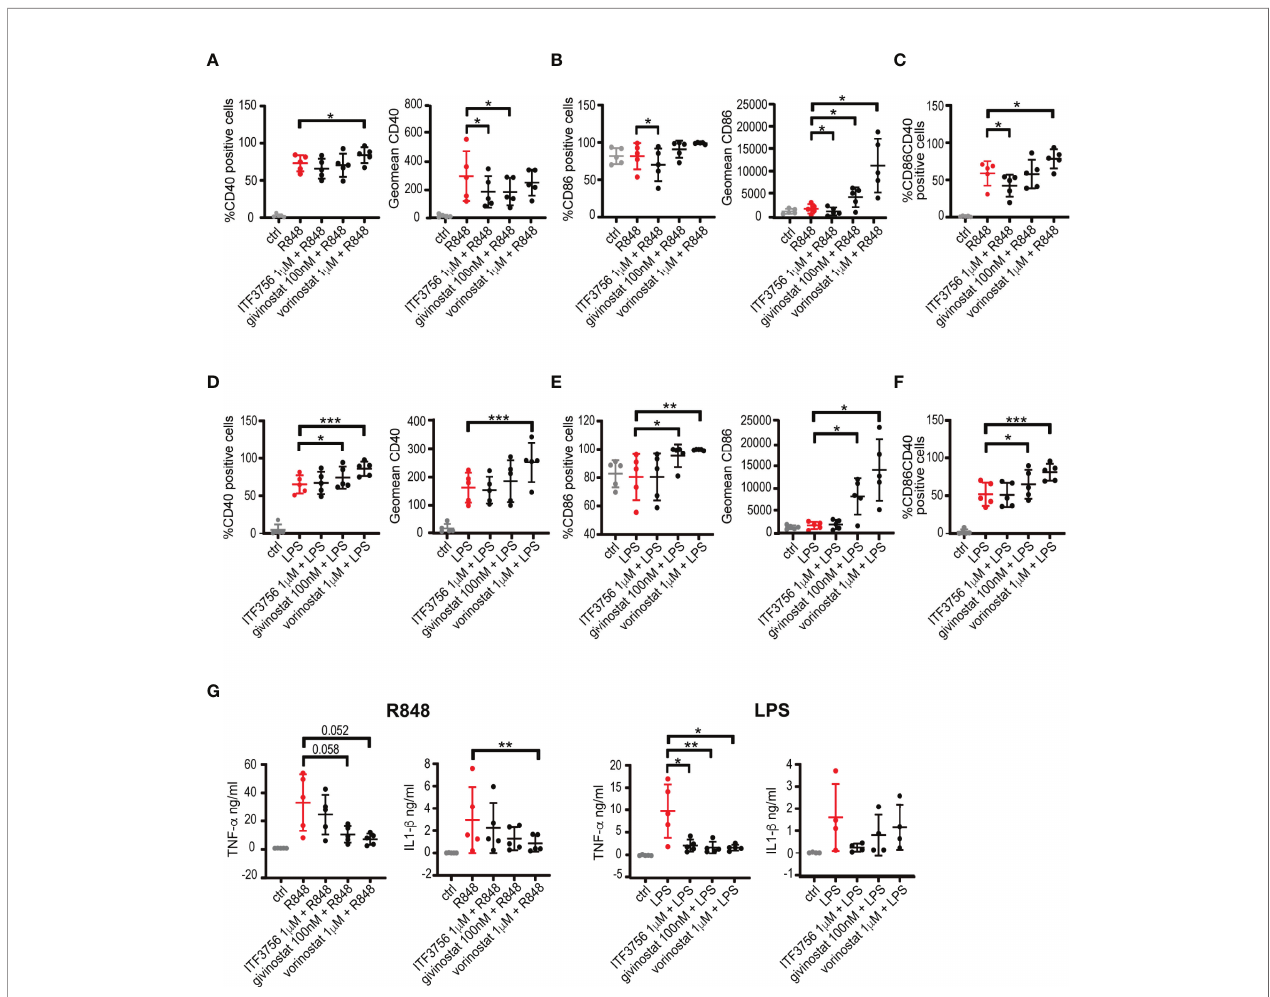
FIGURE 2 | HDACi treatment modulates CD40 and CD86 surface markers expression and pro-in fl ammatory cytokines production in LPS or R848 stimulated monocytes. Human puri fi ed monocytes pre-treated with HDACi were stimulated with LPS (1 m g/ml) or R848 (5 m g/ml) and incubated ON. After incubation, cells were collected and stained with CD14, CD40 and CD86 antibodies and analysed by fl ow cytometry. Gate were performed on CD14 + population and dead cells were eliminated using Forward and Side scatters. Supernatants were collected and analysed for cytokines production. (A – C) Monocytes stimulated with R848: (A) percentage of positive cells and expression of CD40 (B) percentage of positive cells and expression of CD86 (C) CD40 + /CD86 + double positive cells. (D – F) Monocytes stimulated with LPS: (D) percentage of positive cells and expression of CD40 (E) percentage of positive cells and expression of CD86 (F) CD40 + /CD86 + double positive cells. (G) TNF- a and IL-1 b production in R848 or LPS stimulated monocytes. Values on the graphs represent the mean ± SD obtained from 4 or more different donors analyzed in 3 separate experiments. P values were calculated by RM one-way ANOVA as described in material and methods for all samples. *P < 0.05, **< 0.01, ***< 0.001. Geomean is the geometrical mean fl uorescence